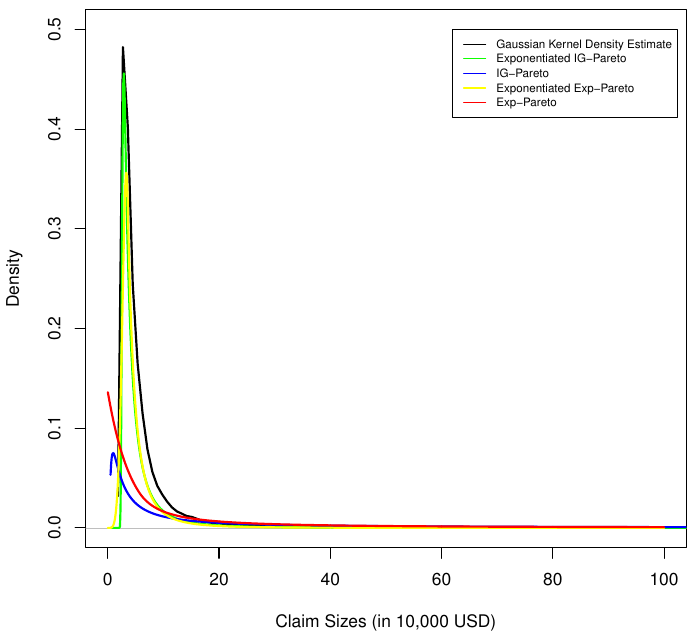
Figure 10. Kernel density estimate of SOA group medical claims data, with corresponding exponenti- ated exp-Pareto, exp-Pareto, exponentiated IG-Pareto, and IG-Pareto fit.